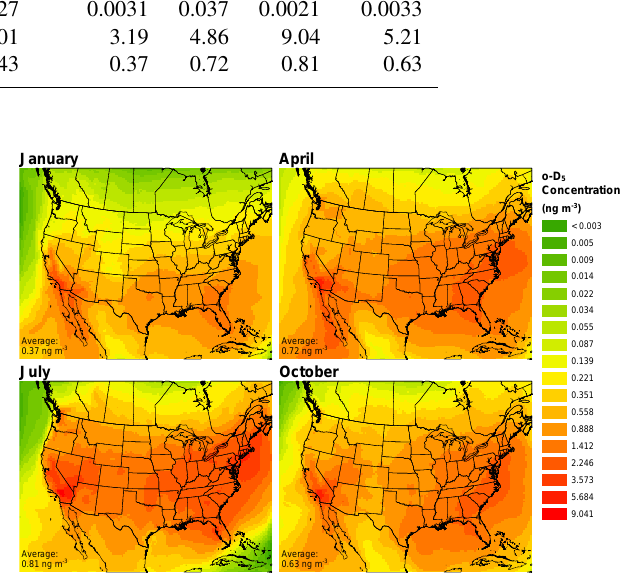
Figure 2. Monthly average surface layer oxidized D 5 (o-D 5 ) con- centrations. The domain average concentration is shown in the lower left for each